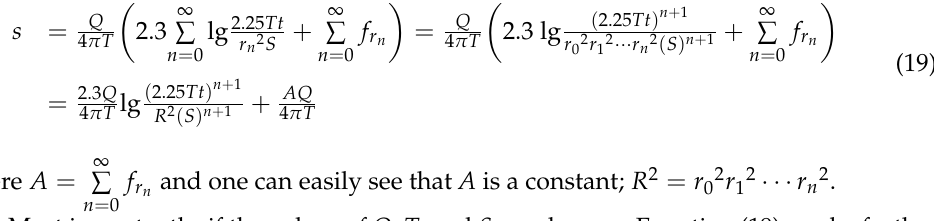
Figure 2. Plan view of a fully penetrated waterproof curtain. Most importantly, if the values of Q ， T , and S s are known, Equation (19) can be fur- ther expressed as